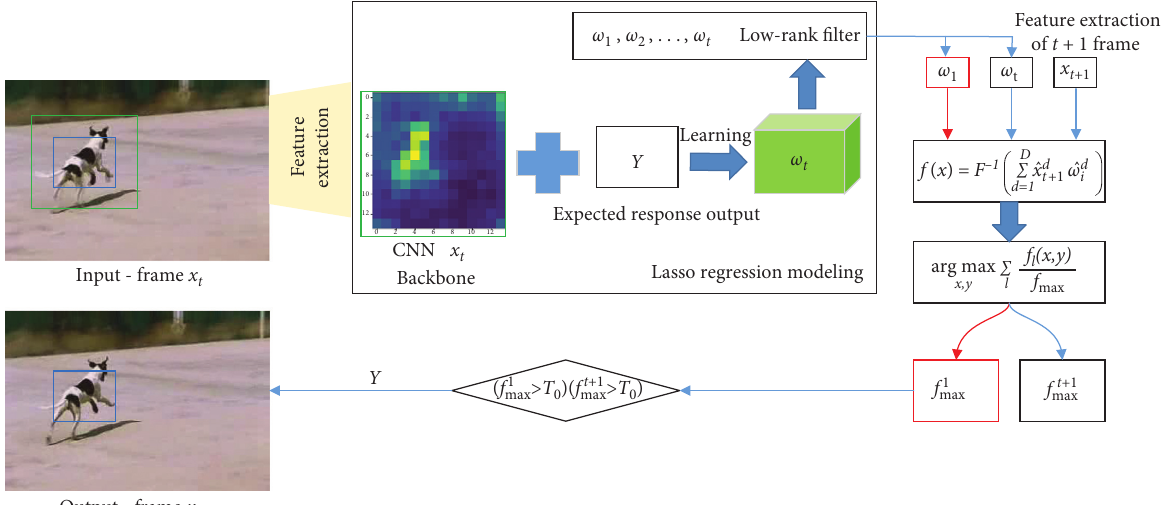
Figure 1: Algorithm model. In frame t , the blue box presents the prediction result of the previous frame and the green box presents the searching area with 1.5 padding. The convolution features are extracted from the original image within the green box. In frame t +1, features for the prediction are extracted around the location in the previous image. The response of the candidate region is calculated by the trained filter ω i , and the position with the maximum response value is the predicted target